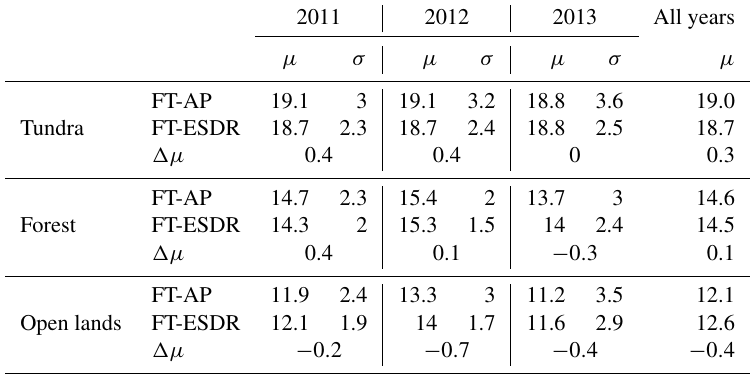
Table 4. Means ( µ ), standard deviation ( σ ) and mean difference ( (cid:49)µ ) between products of thaw onset date (week of the year) for each land